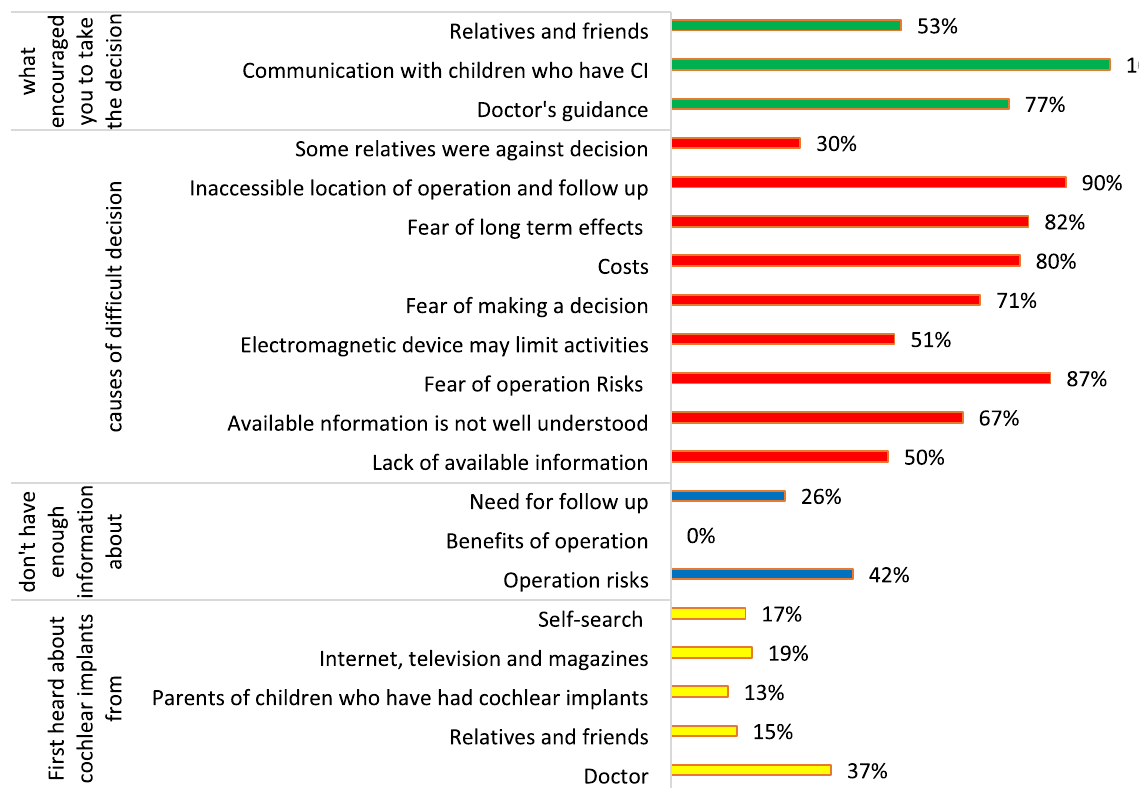
Fig. 2 The experience of decision making by parents of children with cochlear implants. CI: cochlear